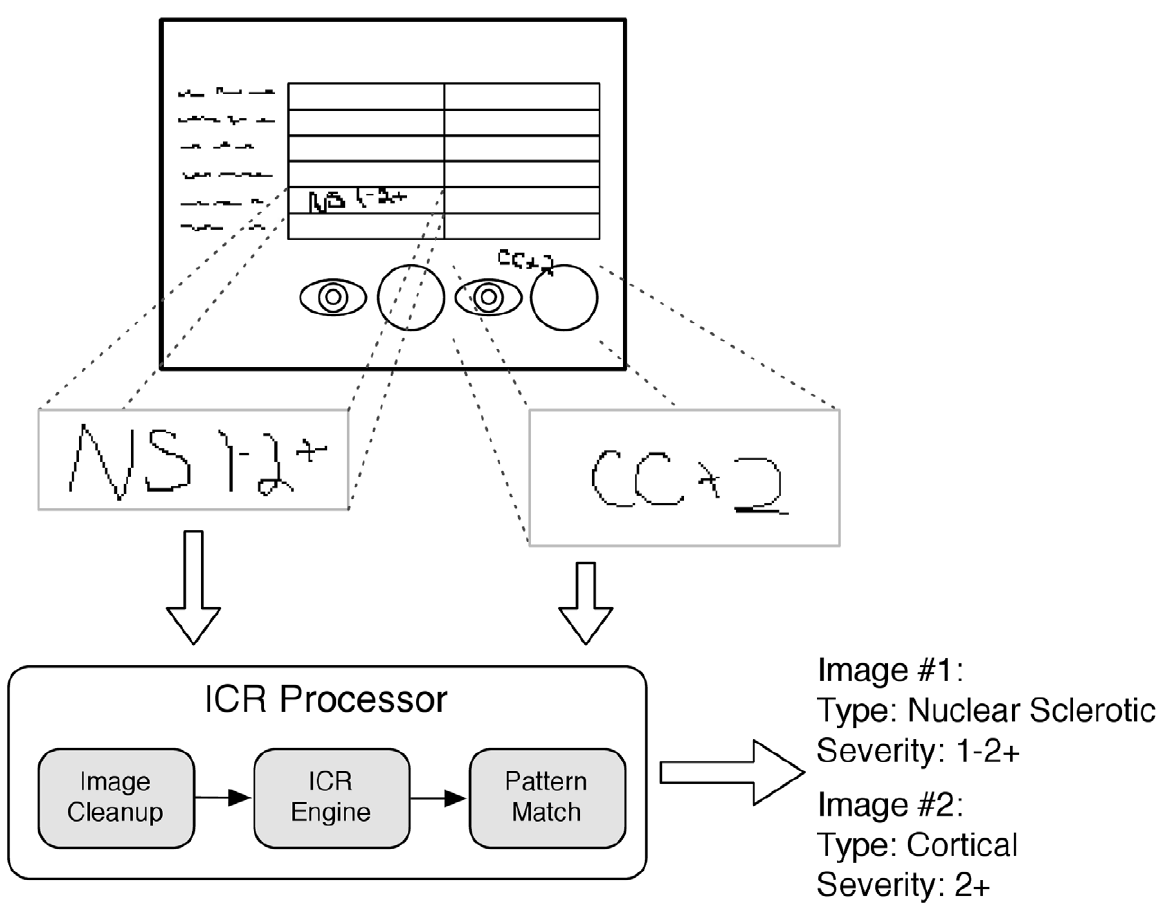
Figure 2. Use of Intelligent Character Recognition to codify handwriting. Figure courtesy of Luke Rasmussen, Northwestern University.